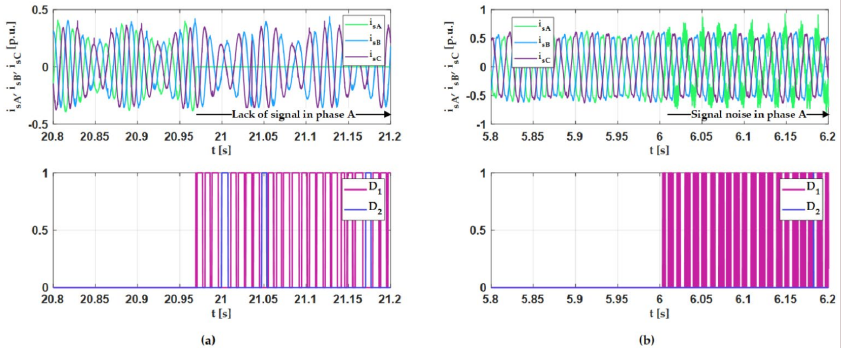
Figure 20. Phase currents underlack of signal ( a ) and signal noise ( b ) in phase A and detector responses in scalar control structure on experimental set-up.